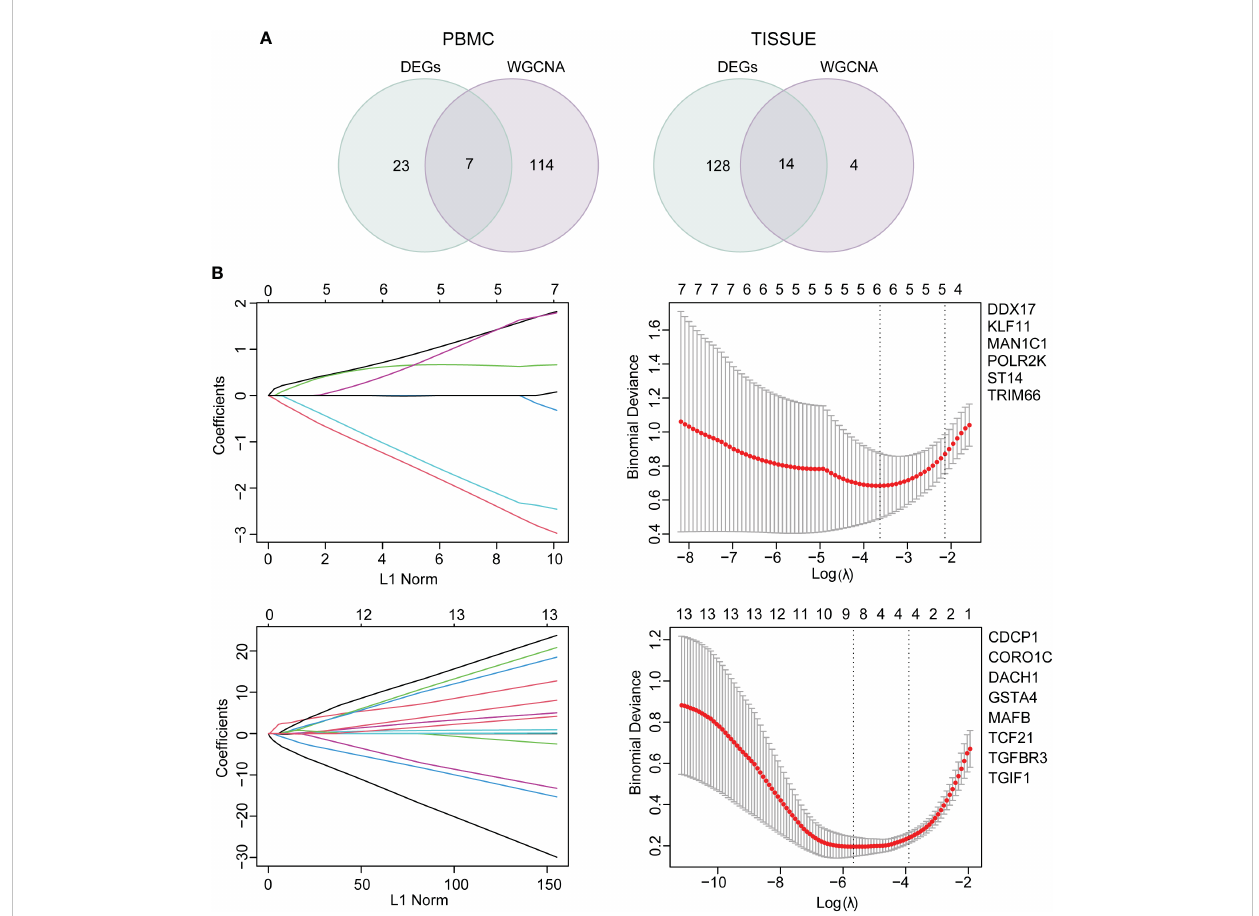
FIGURE 6 Common hub gene selection and least absolute shrinkage and selection operator (LASSO) analysis (A) The common hub genes shared between DEGs and hub genes were visualized in a Venn diagram. Left, PBMC; right, TISSUE. (B) The number of factors was determined by LASSO analysis. The procedure of LASSO Cox model fi tting was shown in left panel. One curve represented a gene. The coef fi cient of each gene against the LC-norm was plotted with the lambda change. L1-norm represented the total absolute value of non-zero coef fi cients. A coef fi cient pro fi le generated against the log (lambda) sequence was shown in the right panel. Continuous upright lines were the partial likelihood deviance ± SE; The optimal values and gene symbols were depicted, based on the minimum criteria (lambda.min, left vertical dotted line) and 1-SE criteria (lambda.1se, right vertical dotted line). Top, PBMC; bottom, TISSUE. SE, standard